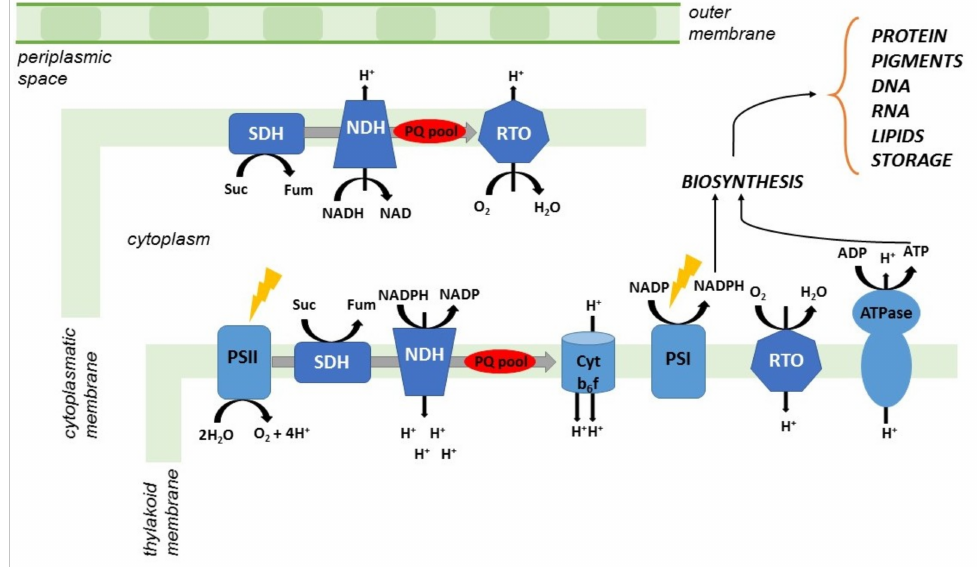
Figure 3. Schematic representation of the intersecting photosynthetic and respiratory electron transport pathways of the cyanobacterium Synechocystis sp. PCC